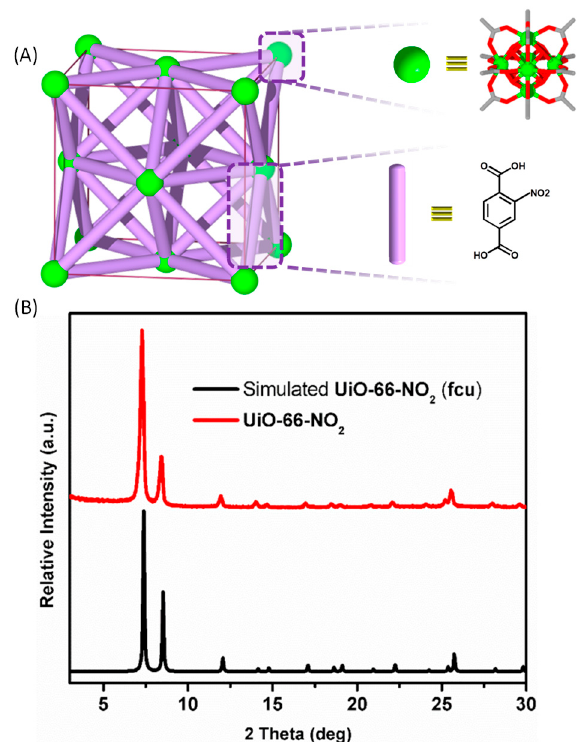
Figure 1. ( A ) Structural representation of UiO-66-NO 2 constructed from 12-c Zr nodes and linear 2-nitroterephthalic acid (H 2 BDC-NO 2 ) ligand. ( B ) Powder X-ray diffraction (PXRD) pattern of the as-synthesized sample matched well with the simulated UiO-66-NO 2 .